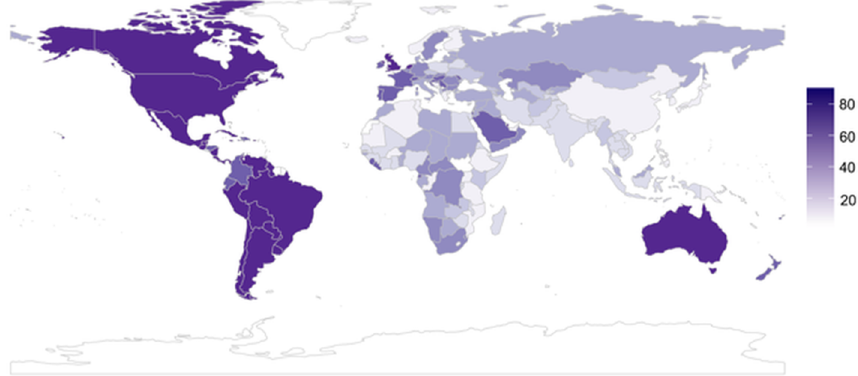
Fig 1. The number of source countries to the countries of the world since A.D. 1500. Darker colors indicate greater number of source countries. From Putterman and Weil [37] World Migration